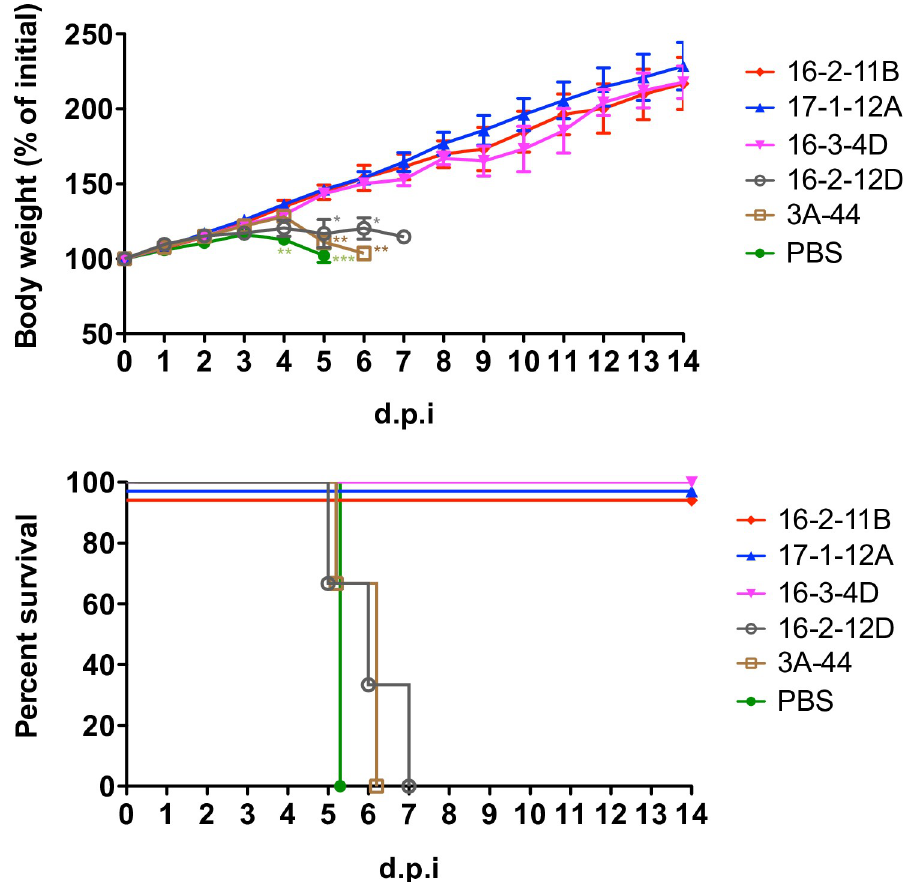
Fig 4. The in vivo protection by genotype C1 EV-A71-neutralizing MAbs. The hSCARB2-transgenic mice were administered with 16-2-11B, 17-1-12A, and 16-3-4D at 10 mg per Kg 24 hours prior to a lethal challenge of genotype C1 EV-A71 TW-5011-2018 (n = 3 per group). Weight change following infection and survival rate were measured. Non-neutralizing anti-EV-A71 canyon MAb 16-2-12D and anti-avian influenza H7 MAb 3A-44 were human IgG controls. The weight data are presented as the means ± standard error of the mean and the comparison of weight change among groups was analyzed using one-way ANOVA followed by Tukey’s post hoc analysis. � , p < 0.05; �� , p < 0.01; ��� , p < 0.001. d.p.i, day post